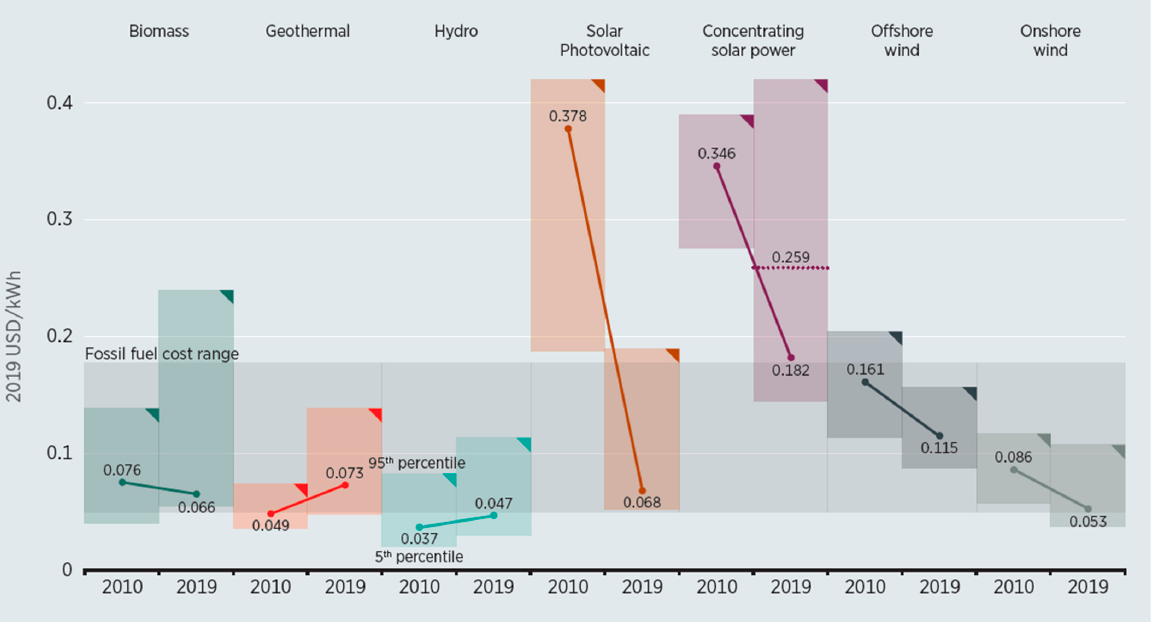
Figure 6. The global weighted average levelized cost of electricity (LCOE) from utility-scale renewable power generation technologies between 2010 and 2019. Reproduced with permission from ref. [46]. Copyright © IRENA 2020.